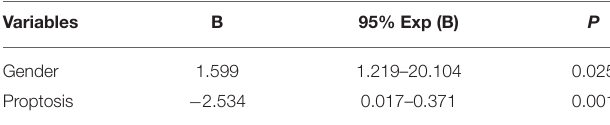
TABLE 3 | Clinical and histological features of patients with ocular tumors. Variables